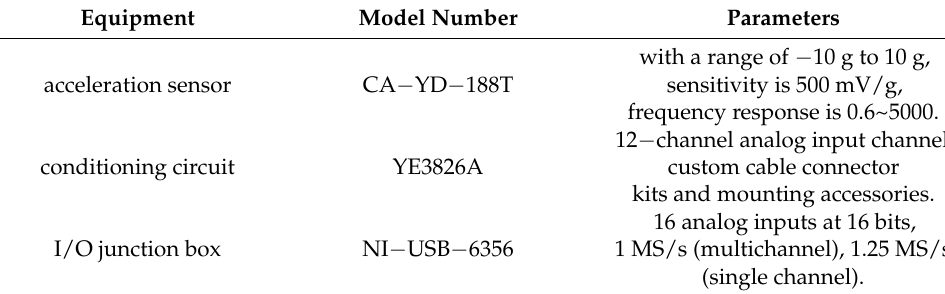
Figure 6. The experimental system. Table 5. Experimental equipment parameters.